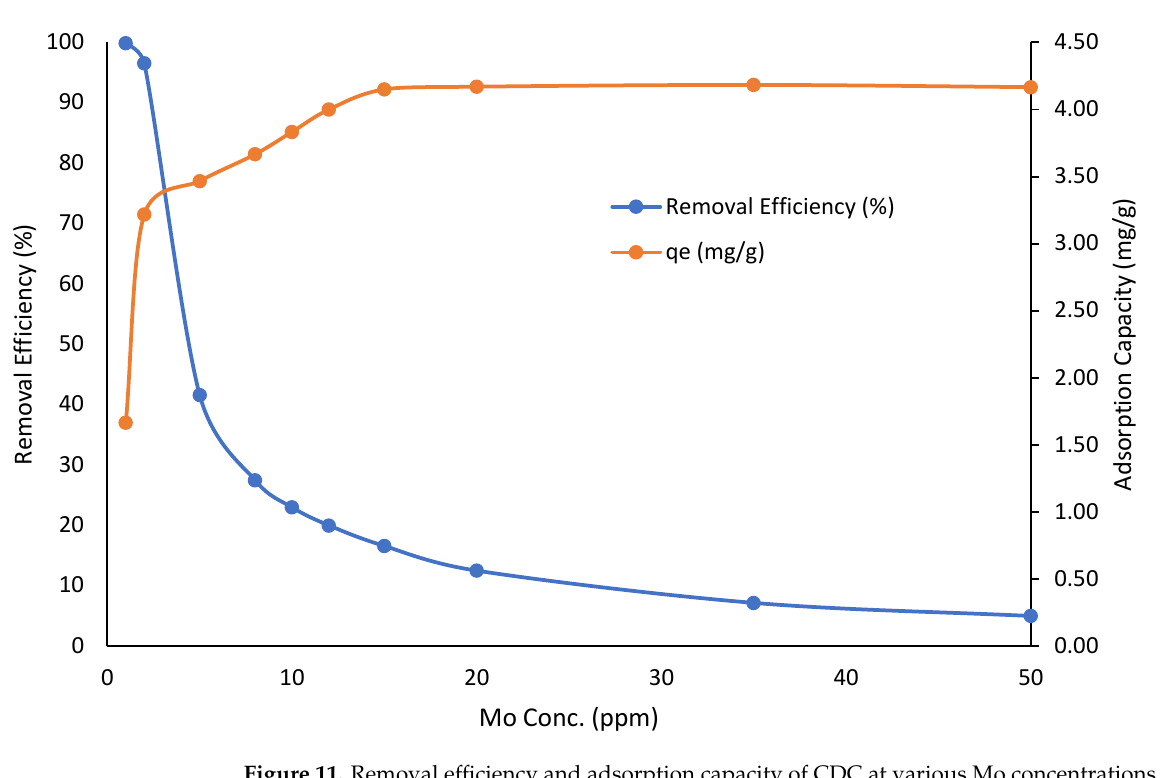
Figure 11. Removal efficiency and adsorption capacity of CDC at various Mo concentrations (ppm); Table 3. Main findings reported in the literature for the removal of some heavy metals from water by adsorption onto various adsorbents, in addition to the present work.